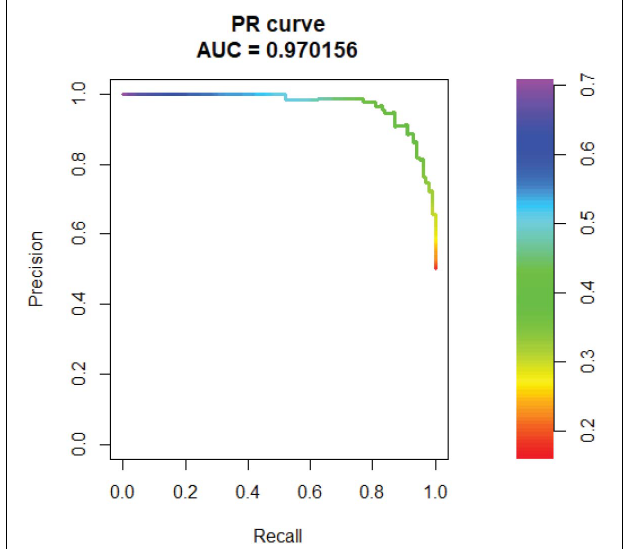
FIGURE 6 | PR curves of Support Vector Machine